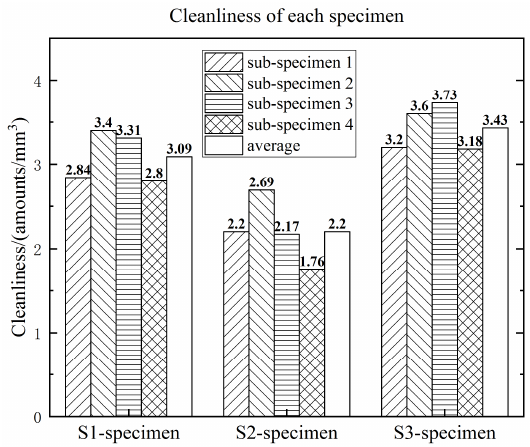
Figure 9. Cleanliness histogram of specimen in each of strands.